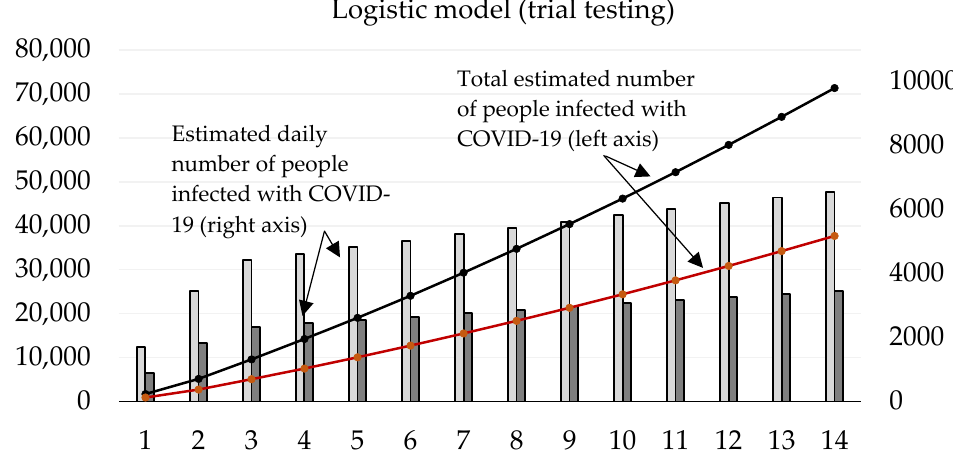
Figure 3. Forecast of the cumulative number of infected people (caused by those who would not be discovered by trial testing) based on the logistic model.